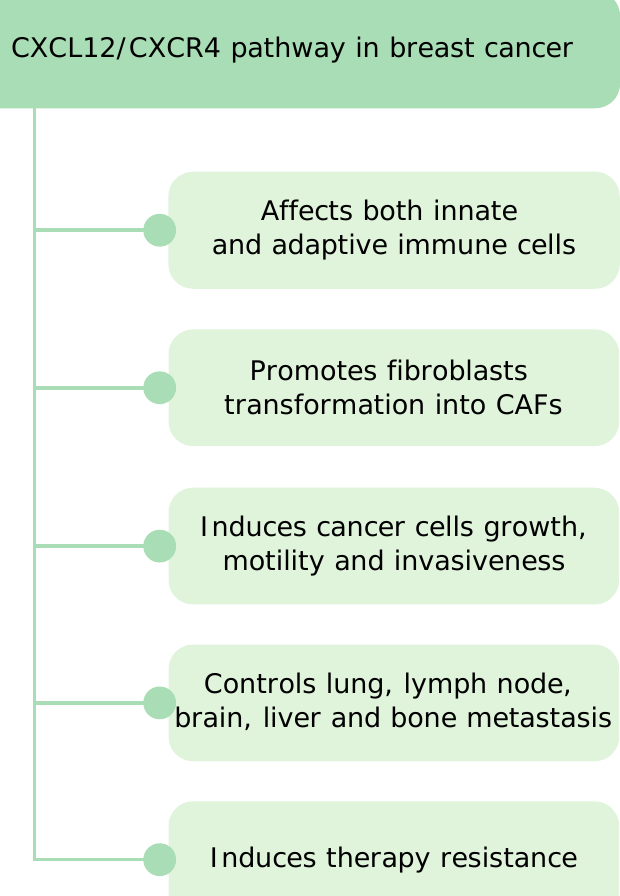
Figure 3. Various aspects of how the CXCL12 / CXCR4 signaling controls breast cancer tumorigenesis. It a ff ects both innate and adaptive immunity and induces transformation of fibroblasts into CAFs. Moreover, CXCL12 / CXCR4 is implicated in disease progression and metastasis to distant organs such as lungs, lymph nodes, brain, liver and bones. Finally, activation of this signaling pathway might lead to therapy